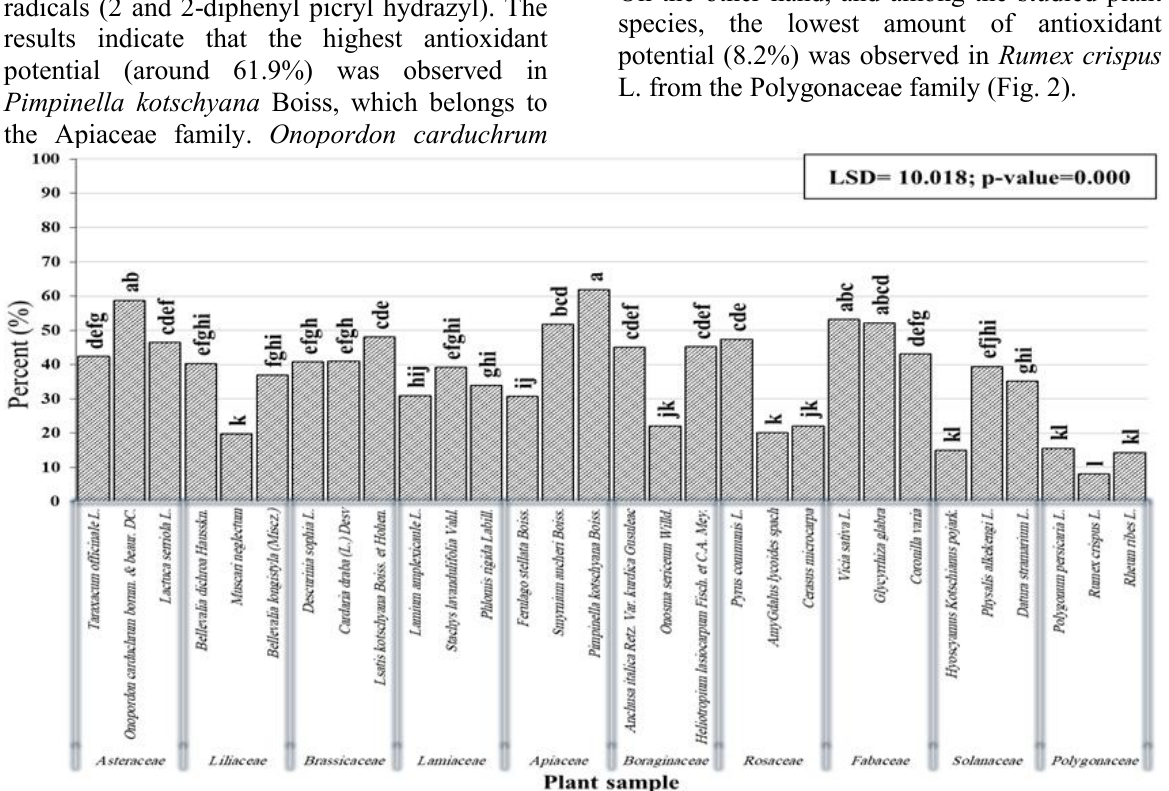
Fig. 2. Comparison between antioxidant capacities of studied plant species using DPPH